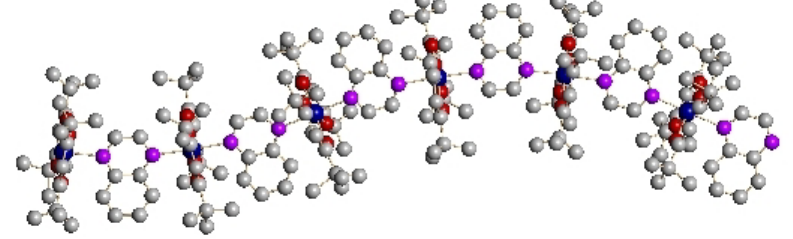
(qox)] ( 4 ), showing the asymmetric 2 n